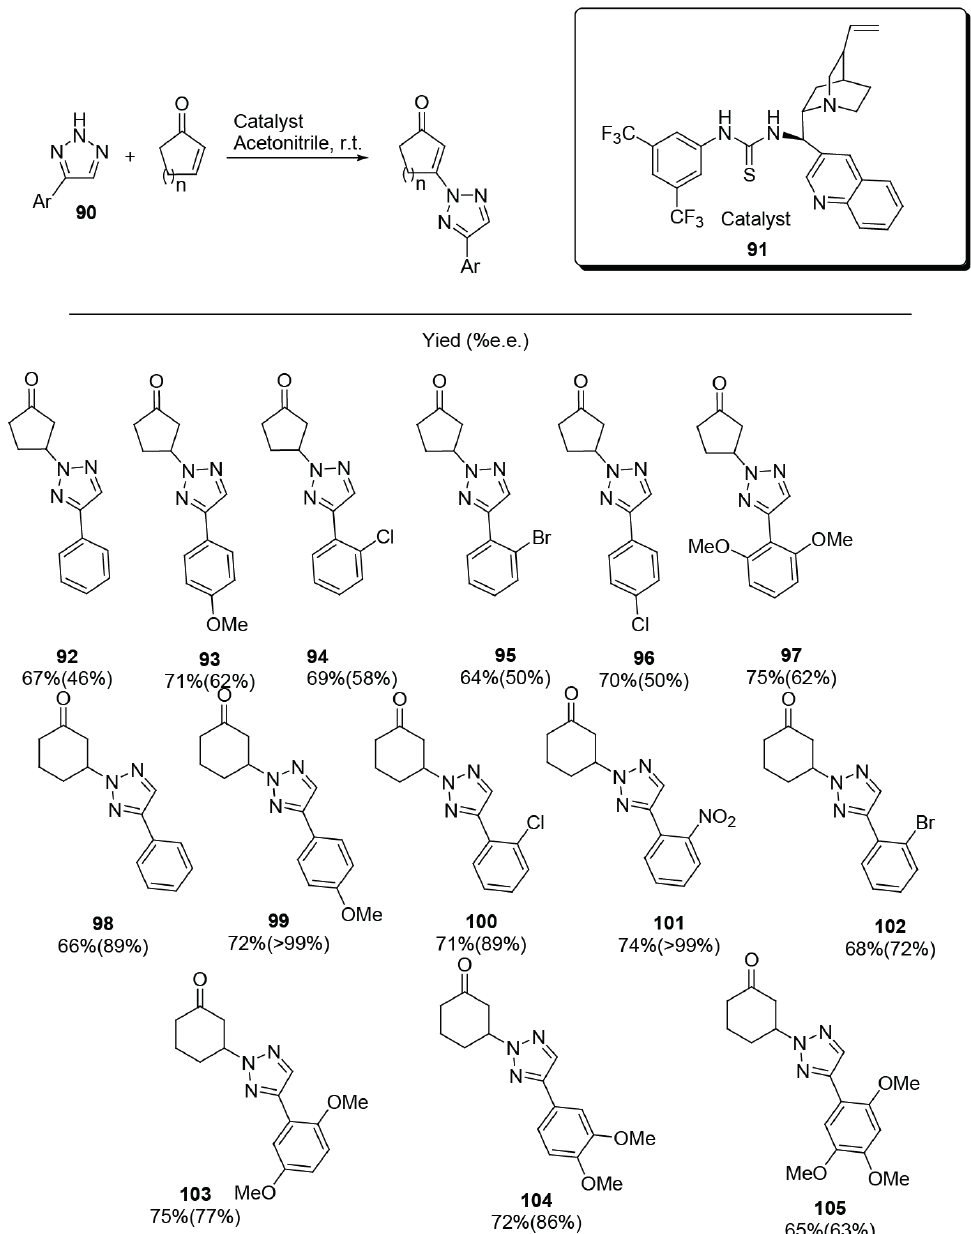
Figure 16 - The regio and enantioselectiveaza-michael reaction of 4-aryl-Nh-1,2,3-triazoles to cyclic